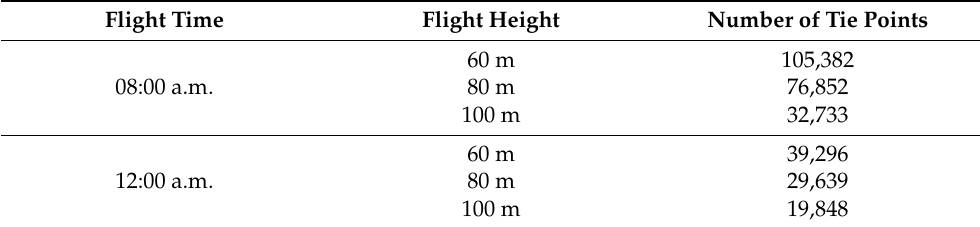
Figure 8. Box-and-whisker plot of RMSE vs. the flight time (8 a.m. and 12 a.m.) for all the flight heights. Table 5. Number of tie